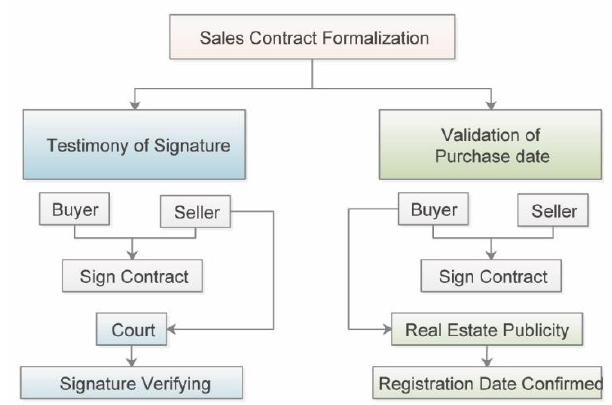
Figure 3: Formalization of Sales Contract - Source: